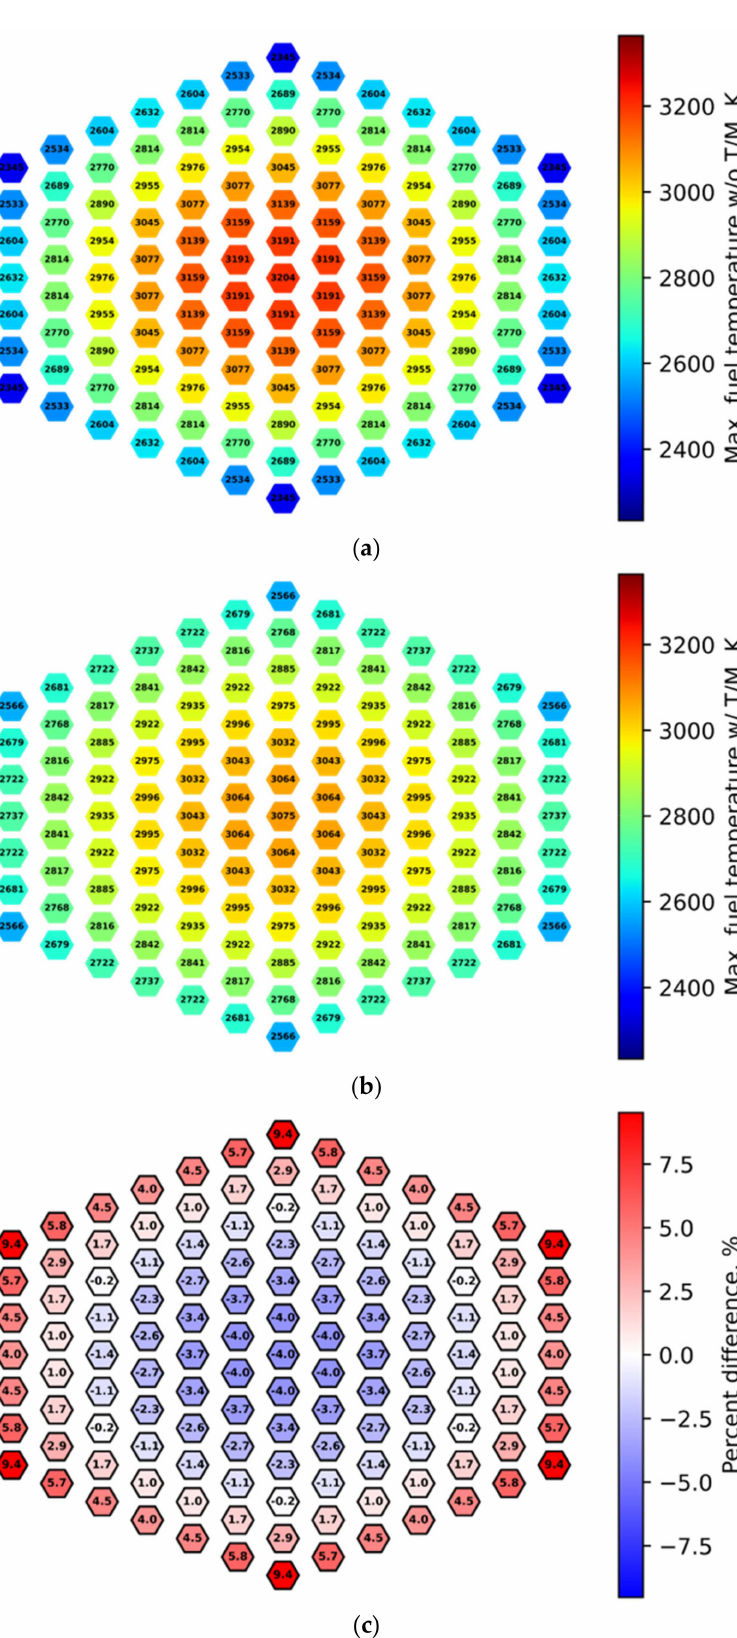
Figure 9. Comparison of maximum fuel temperature ( a ) w/o T/M feedback; ( b ) w/ T/M feedback; ( c ) percent